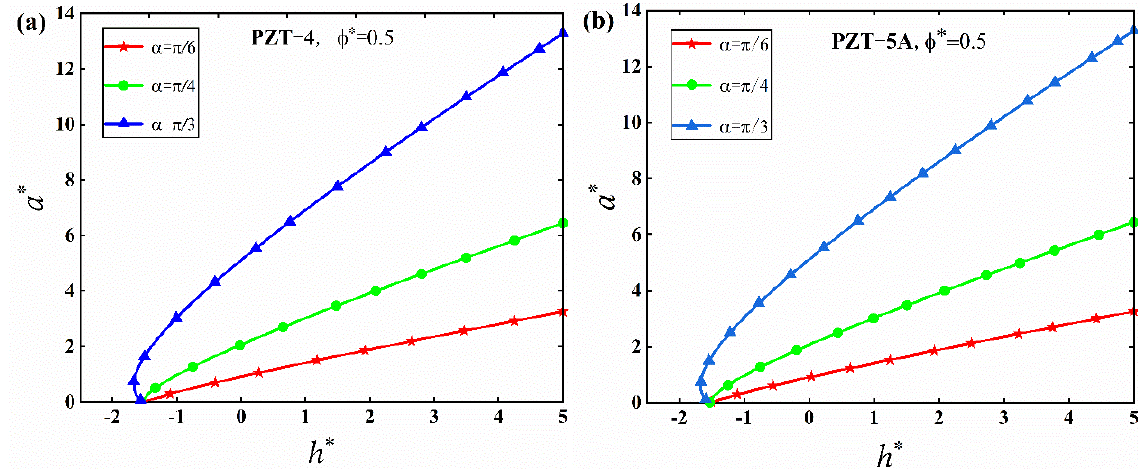
Figure 10. Variation of the dimensionless contact radius, a ∗ , with the dimensionless indentation depth, h ∗ , at the different values of α = π /6, π /4 and π /3 for the conducting punch with zero electric potential and the insulating punch. ( a ) PZT-4. ( b ) PZT-5A. ( c ) BaTiO 3 . ( d ) Ba 0.917 Ca 0.083 TiO 3 .